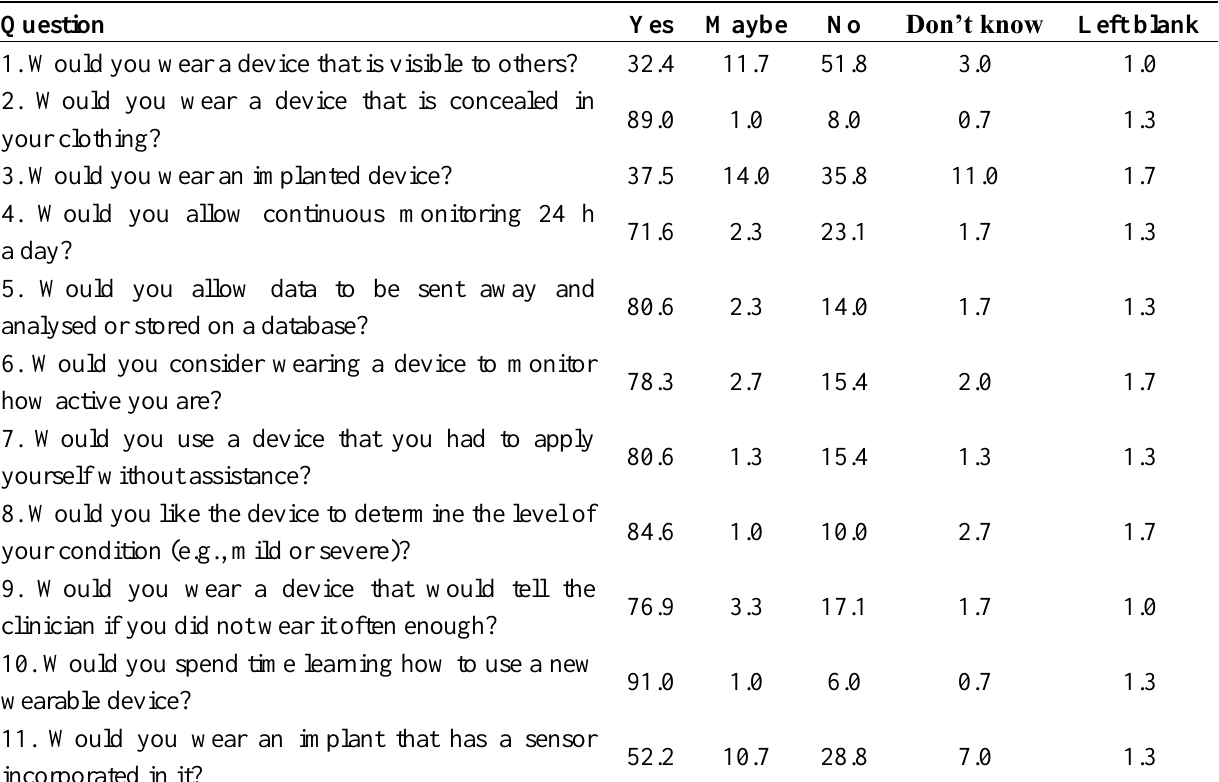
Table 3. Percentage of participants that provided a specific categorical response to a closed question. Answers are given on a 3-point Likert scale, with an additional ―don’t know‖